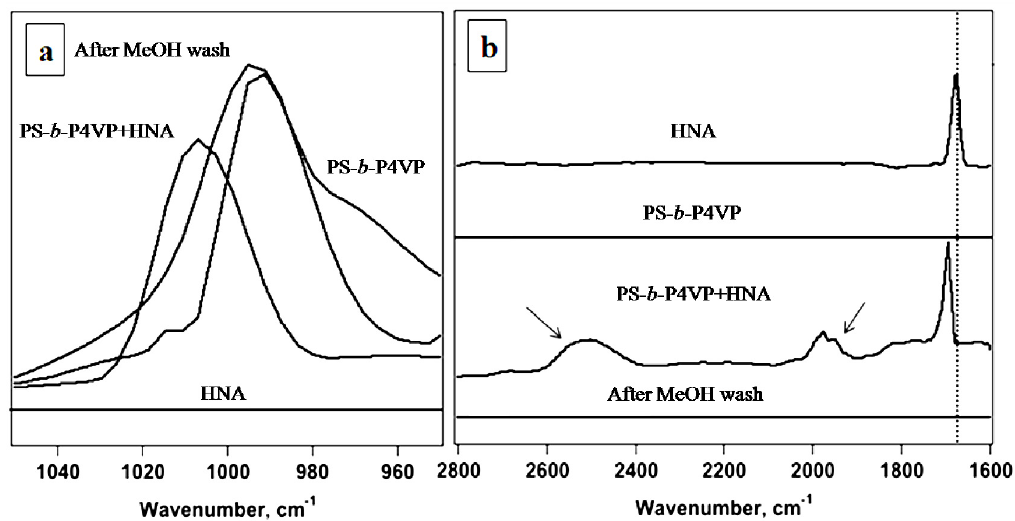
Figure 2. FTIR difference spectra of PS- b- P4VP, HNA, PS- b -P4VP/HNA mixture (4VP/HNA 1:1 molar ratio) and PS- b -P4VP/HNA mixtures after methanol